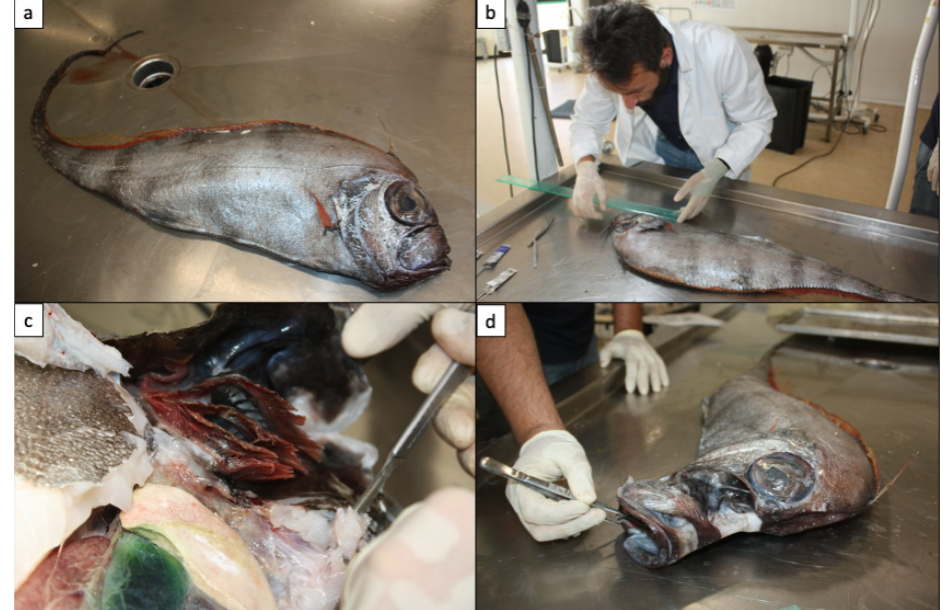
Figure 3. Biometric and meristic data collection of the Z. cristatus specimen during the necroscopy. ( a ) entire specimen; ( b ) measurement check; ( c ) posterior view of gill rakes; ( d ) detail of the maxilla and the premaxilla extension during jaw protrusion.